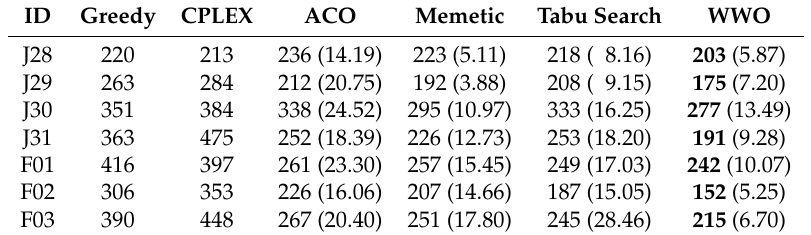
Table 3. Results of the comparative algorithms on the test instances.